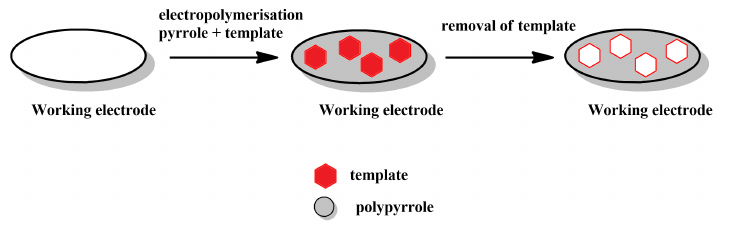
Figure 2. Schematic depiction of the stages comprising the simultaneous polymerisation and imprint- ing approach.